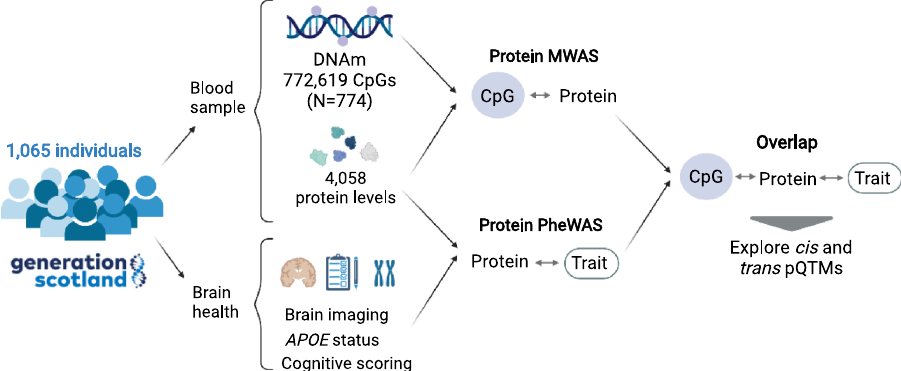
Fig. 1 | Methylome and phenome study of the plasma proteome in relation to brainhealthstudydesign. Atotalof4058plasmaproteins(correspondingto4235 SOMAmers) were measured in 1065 individuals in Generation Scotland. A methylome-wide association study (MWAS) of each plasma protein level was con- ducted in 774 individuals that represented a nested subset of the full sample that had DNAm measurements available. A phenome-wide protein association study